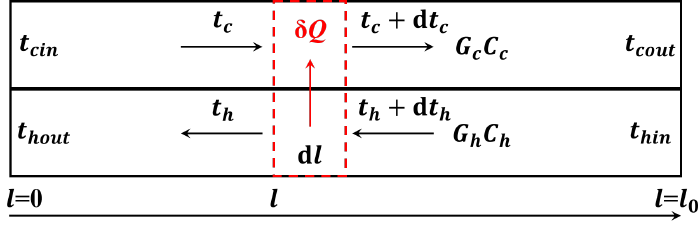
Figure 1. Schematic diagram of a counterflow heat